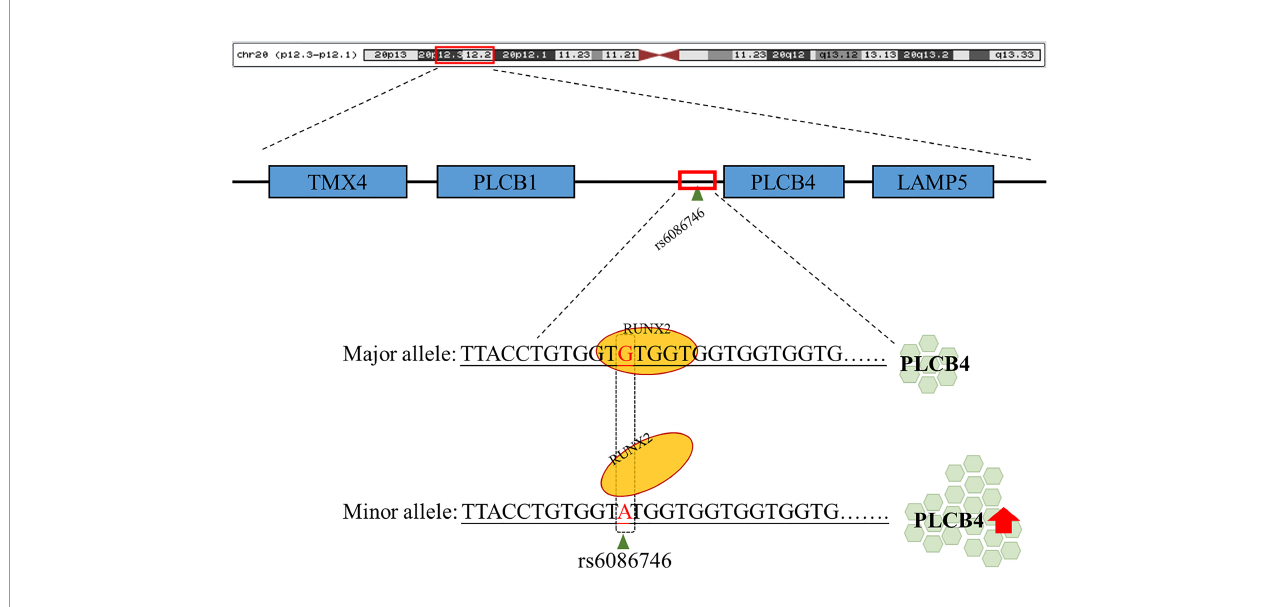
FIGURE 5 | Schematic diagram of the binding of RUNX2 transcription factor to the PLCB4 promoter region. rs6086746 is located in the promoter region of PLCB4, and when G allele is mutated to A allele, it may affect the binding ability of runx2 transcription factors. This prevents the RUNX2 transcription factor from binding to its binding motif, thereby increasing the expression level of the downstream PLCB4